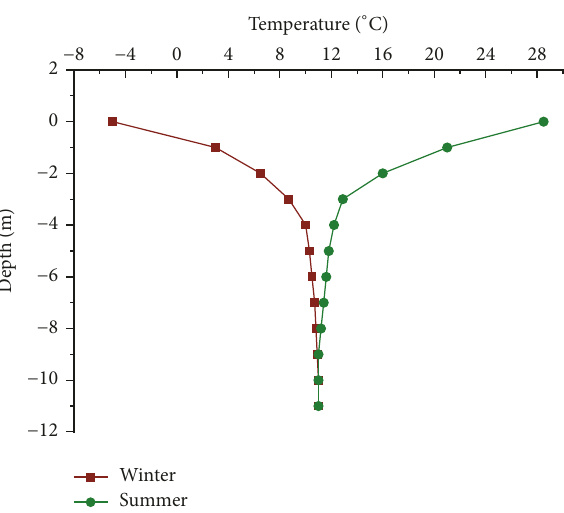
Figure 9: Variation in temperature with